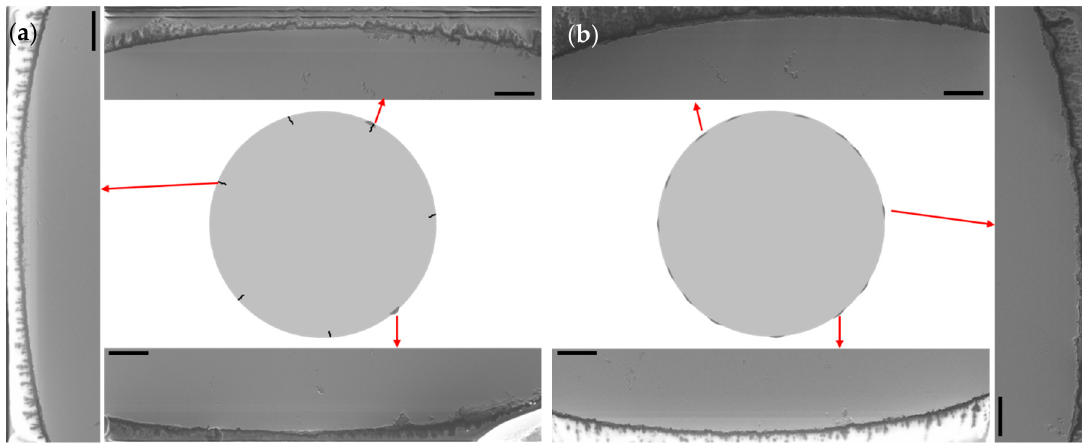
Figure 10. Schematic representation of ( a ) 3VAP and ( b ) 3CNC (no heat ‐ treatment). Cross ‐ sections cut away from fracture zones. Scale of 100 μ m included with each SEM image.